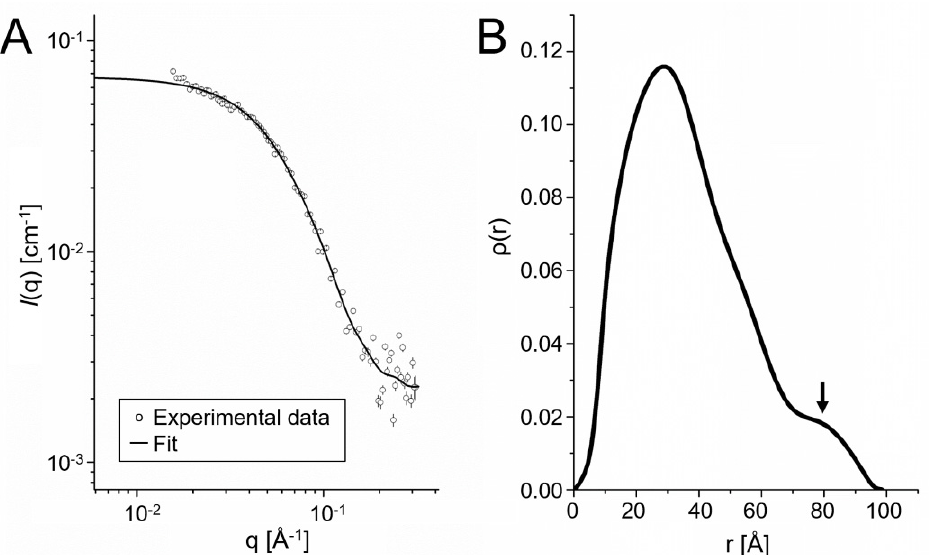
Figure 5. SAXS data for ETE in the buffer solution MES 20 mM, pH 7.0 and 150 mM NaCl. ( A ) Intensity SAXS profile. ( B ) Pair distance distribution function ( ρ (r)). I and q stand for the intensity and the scattering vector, respectively. The arrow indicates the shoulder in the ρ (r) distribution, which is interpreted as a signature of dimerization.